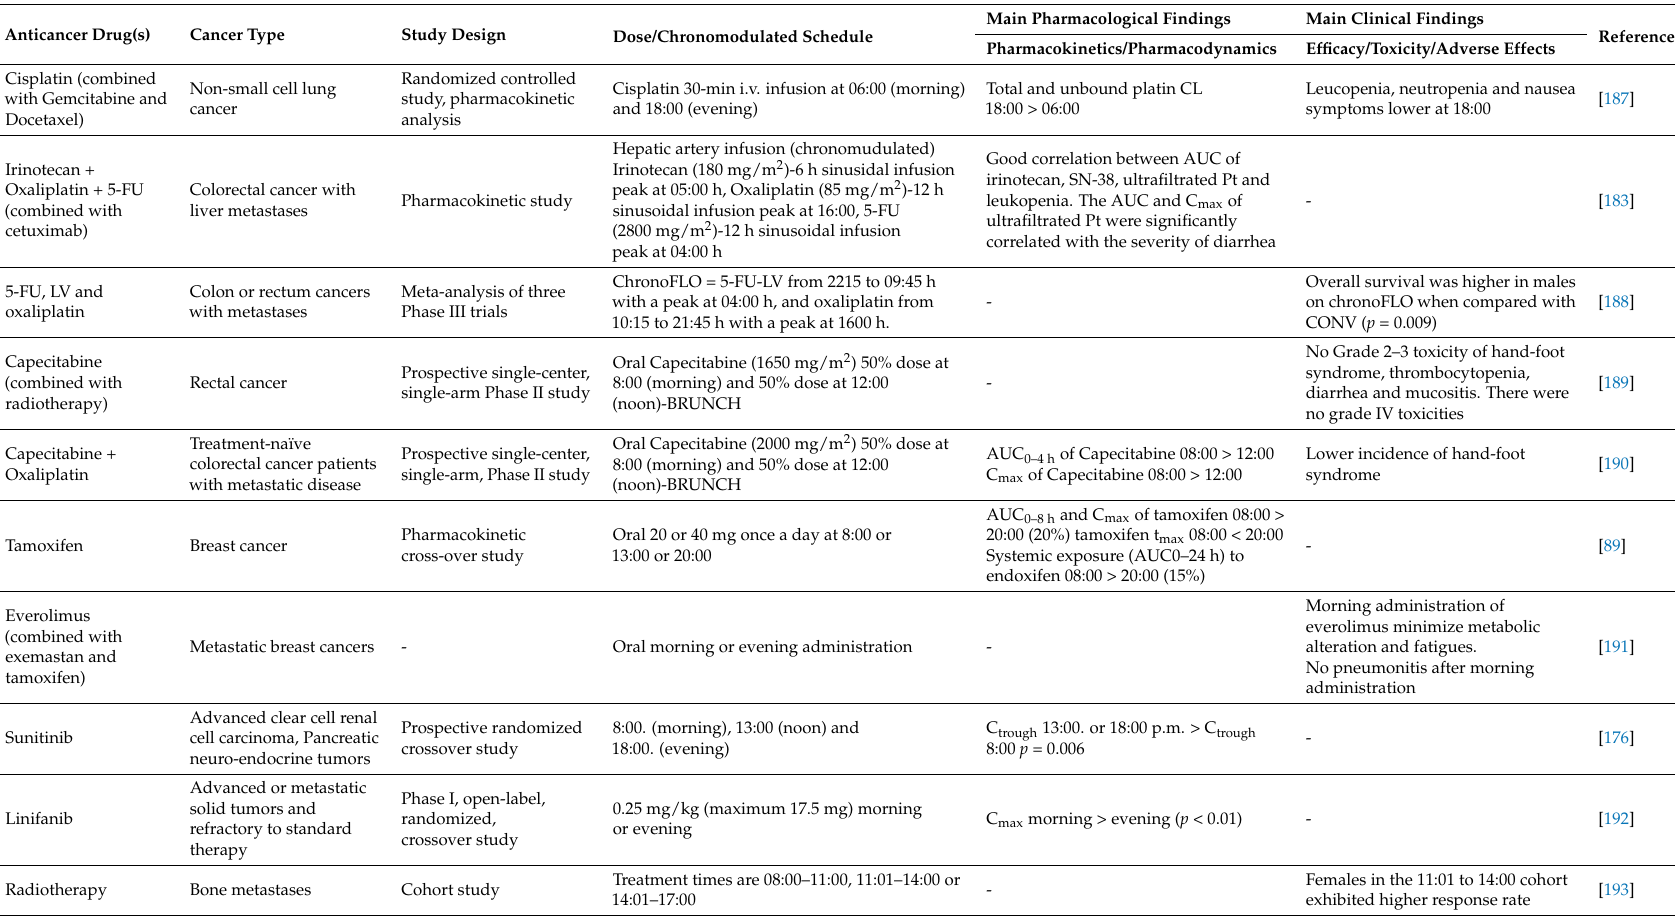
Table 4. Examples from the literature on relationship between circadian clock and cancer treatment at clinical